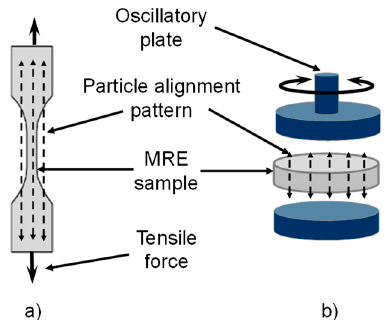
Figure 3. During the polydimethylsiloxane (PDMS) curing and manufacture process, the samples were exposed to a magnetic flux density of 52 mT to produce a specific magnetic micro particle arrangement. ( a ) Particle alignment along the longitudinal axis of the manufactured tensile samples, and ( b ) particle arrangement inside the rheological test samples.